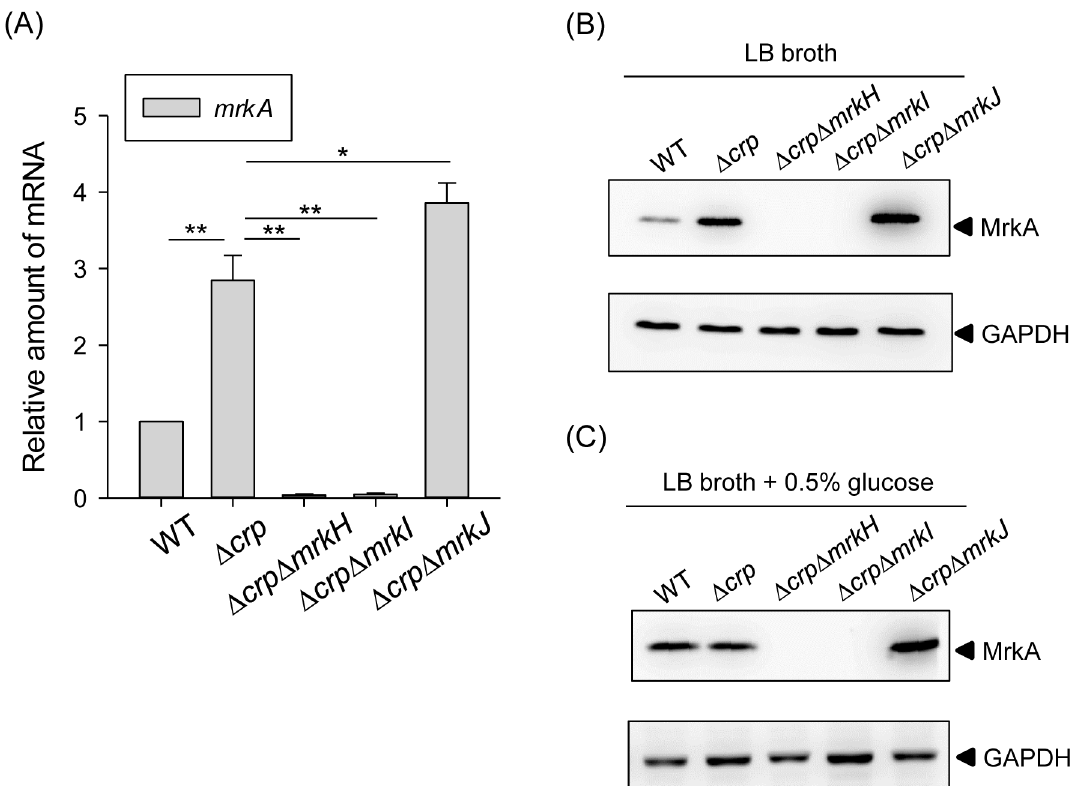
Fig 4. MrkH and MrkI are required for repression of CRP in type 3 fimbriae. (A) qRT-PCR analysis of mrkA expression was measured in WT, Δ crp , Δ crp Δ mrkH , Δ crp Δ mrkI , and Δ crp Δ mrkJ strains in LB medium. The results are representative of three independent experiments. Error bars indicate standard deviations. * P < 0.05 and ** P < 0.01 compared to the indicated group. The MrkA expression of WT, Δ crp , Δ crp Δ mrkH , Δ crp Δ mrkI , and Δ crp Δ mrkJ strains was determined in LB broth without (B) or with 0.5% glucose (C) by Western blot analysis against MrkA (the upper panel) and GAPDH antiserum (the lower panel, for internal control). The MrkA and GAPDH proteins are indicated by an arrow,